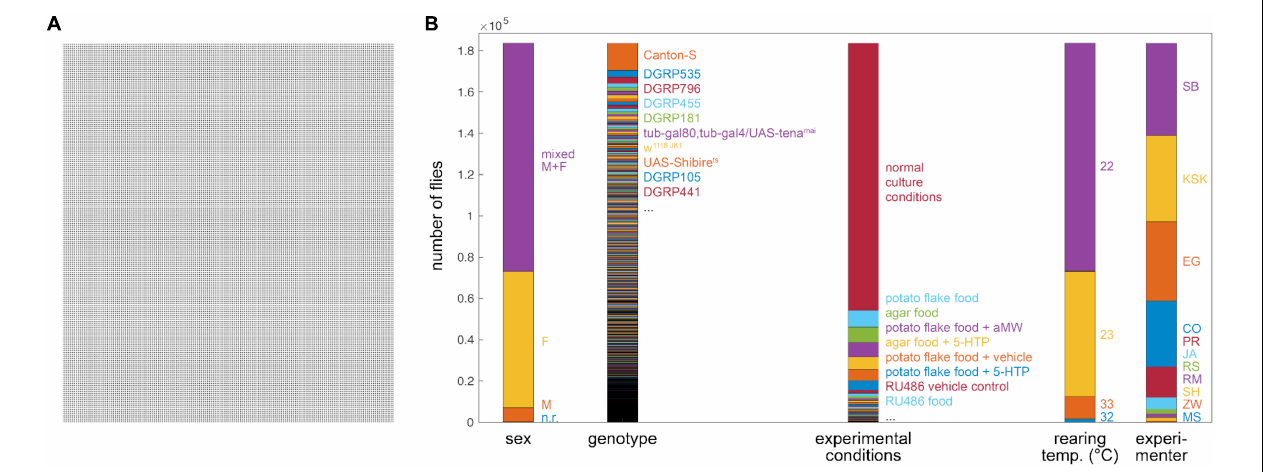
FIGURE 1 | Depiction of grand Y-maze data set ( n = 183,496)— (A) Visualization of 183,496 flies (each dot is a fly). (B) Breakdown of flies into important metadata categories. Height of each color segment indicates the number of flies with that metadata value. Bars align to panel (A) .